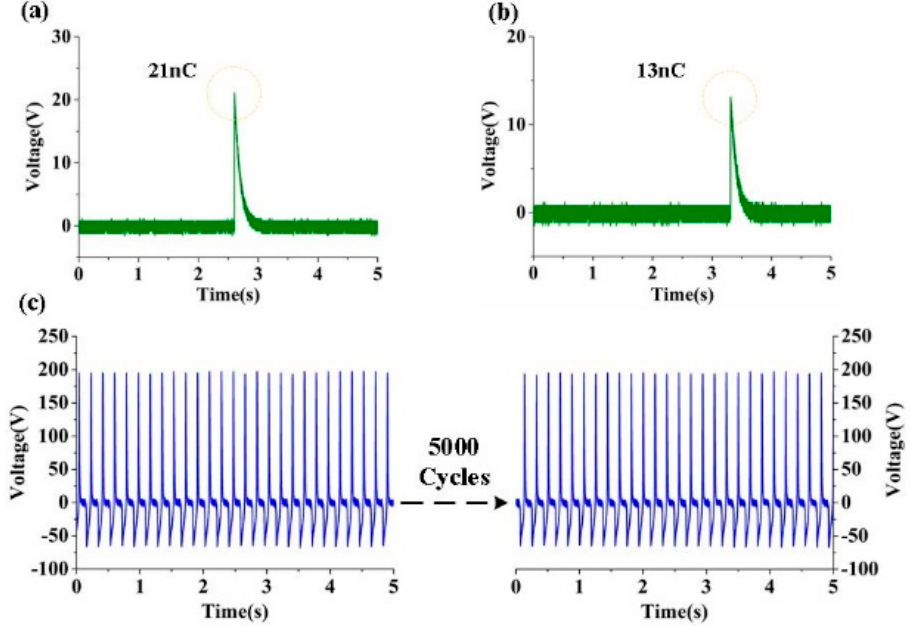
Figure 5. ( a ) The voltage curve of a 1-nF capacitor connected to the TENGs through a full-wave rectifier bridge, and ( b ) conductive copper tape, respectively, which serve as the triboelectric pairs. ( c ) The reliability of the prepared TENG was verified via 5000 cycles of continuous operation.